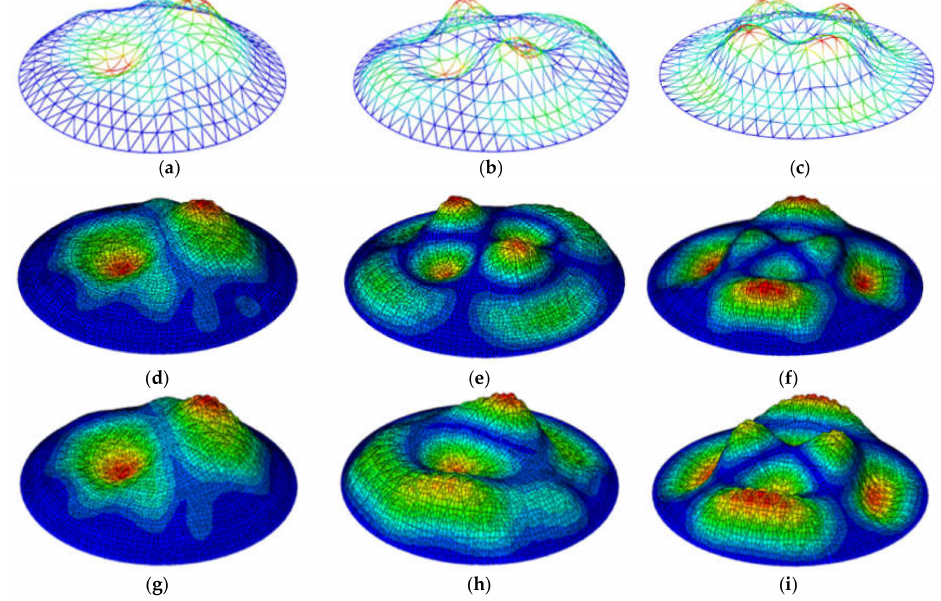
Figure 4. Modal comparison of the shell with various roofing systems: ( a ) D4053-1500-W 1st order (2.52 Hz); ( b ) D4053-1500-W 3rd order (2.70 Hz); ( c ) D4053-1500-W 8th order (2.80 Hz); ( d ) D4053- 1500-LSWM 1st order (2.46 Hz); ( e ) D4053-1500-LSWM 3rd order (2.66 Hz); ( f ) D4053-1500-LSWM 8th order (2.76 Hz); ( g ) D4053-1500-HHWM 1st order (2.73 Hz); ( h ) D4053-1500-HHWM 3rd order (3.02 Hz); ( i ) D4053-1500-HHWM 8th order (3.14